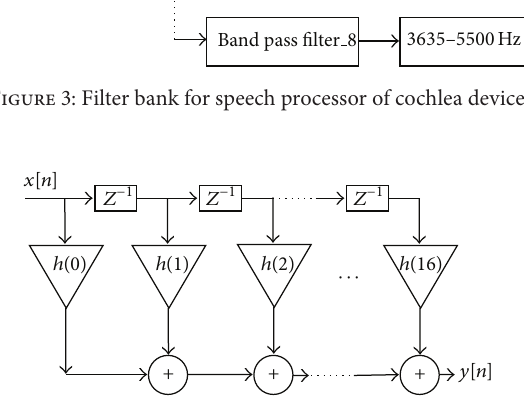
Figure 4: Structure of the FIR filter.